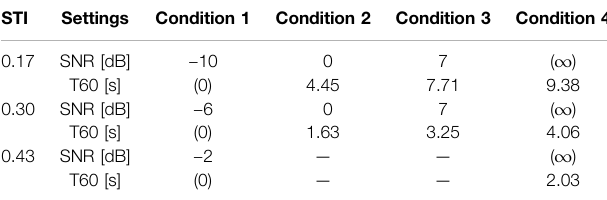
TABLE 1 | Summary of the measurement settings including different combinations of signal-noise-ratio (SNR) and reverberation time (T60).